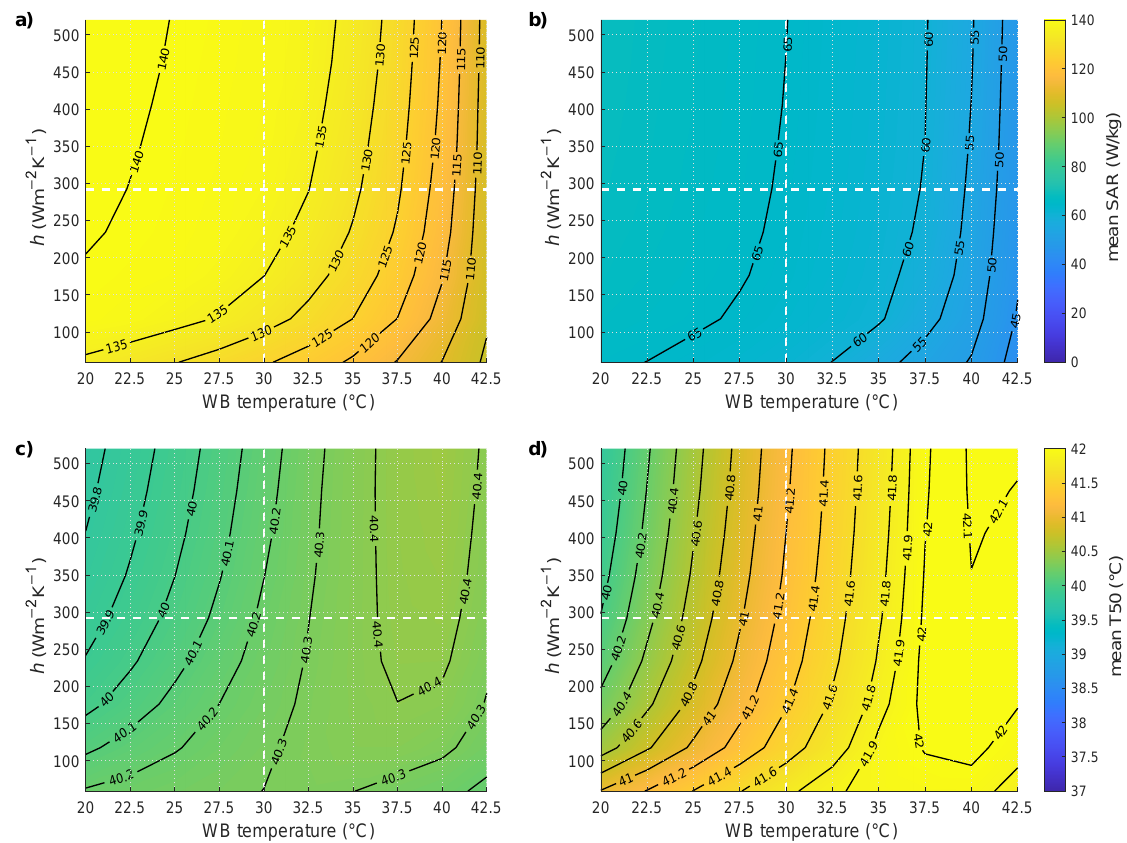
Figure 7. Mean SAR and mean T50 for seven patients from 34 treatments with median CTV depth less than 20 mm as a function of water bolus (WB) temperature and water bolus heat transfer coefficient (h) for ( a , c ) constant model and ( b , d ) temperature-dependent blood perfusion model.